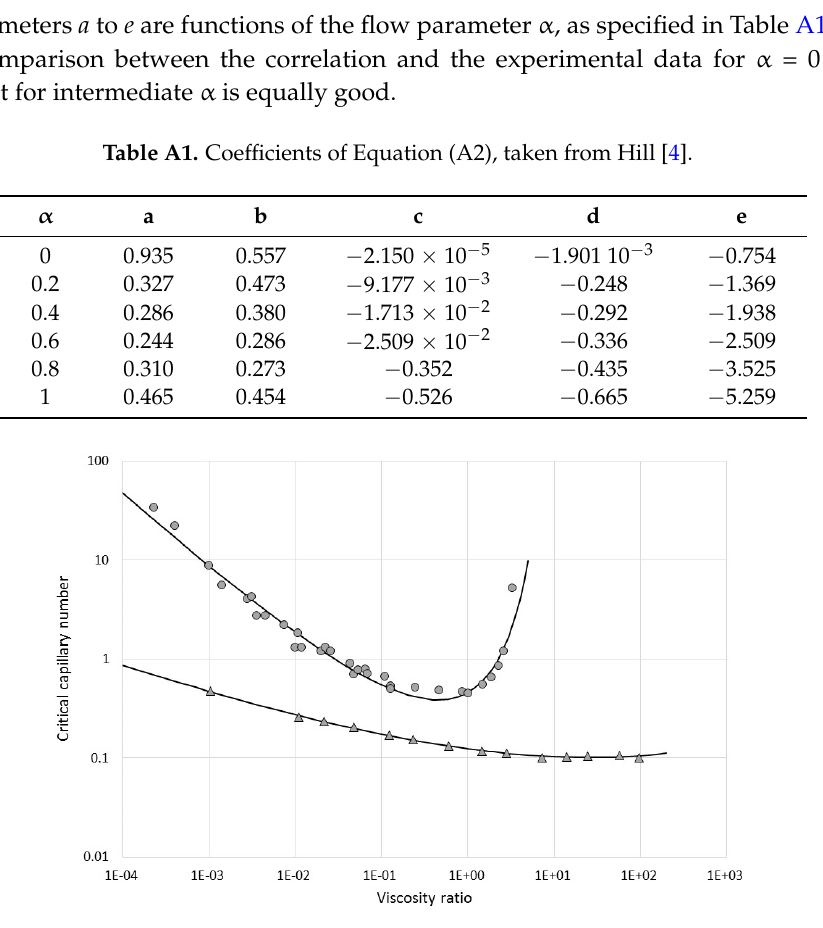
Figure A1. Comparison of the correlation (A2) and the experimental data of Figure 1 for α = 0 and α = 1.